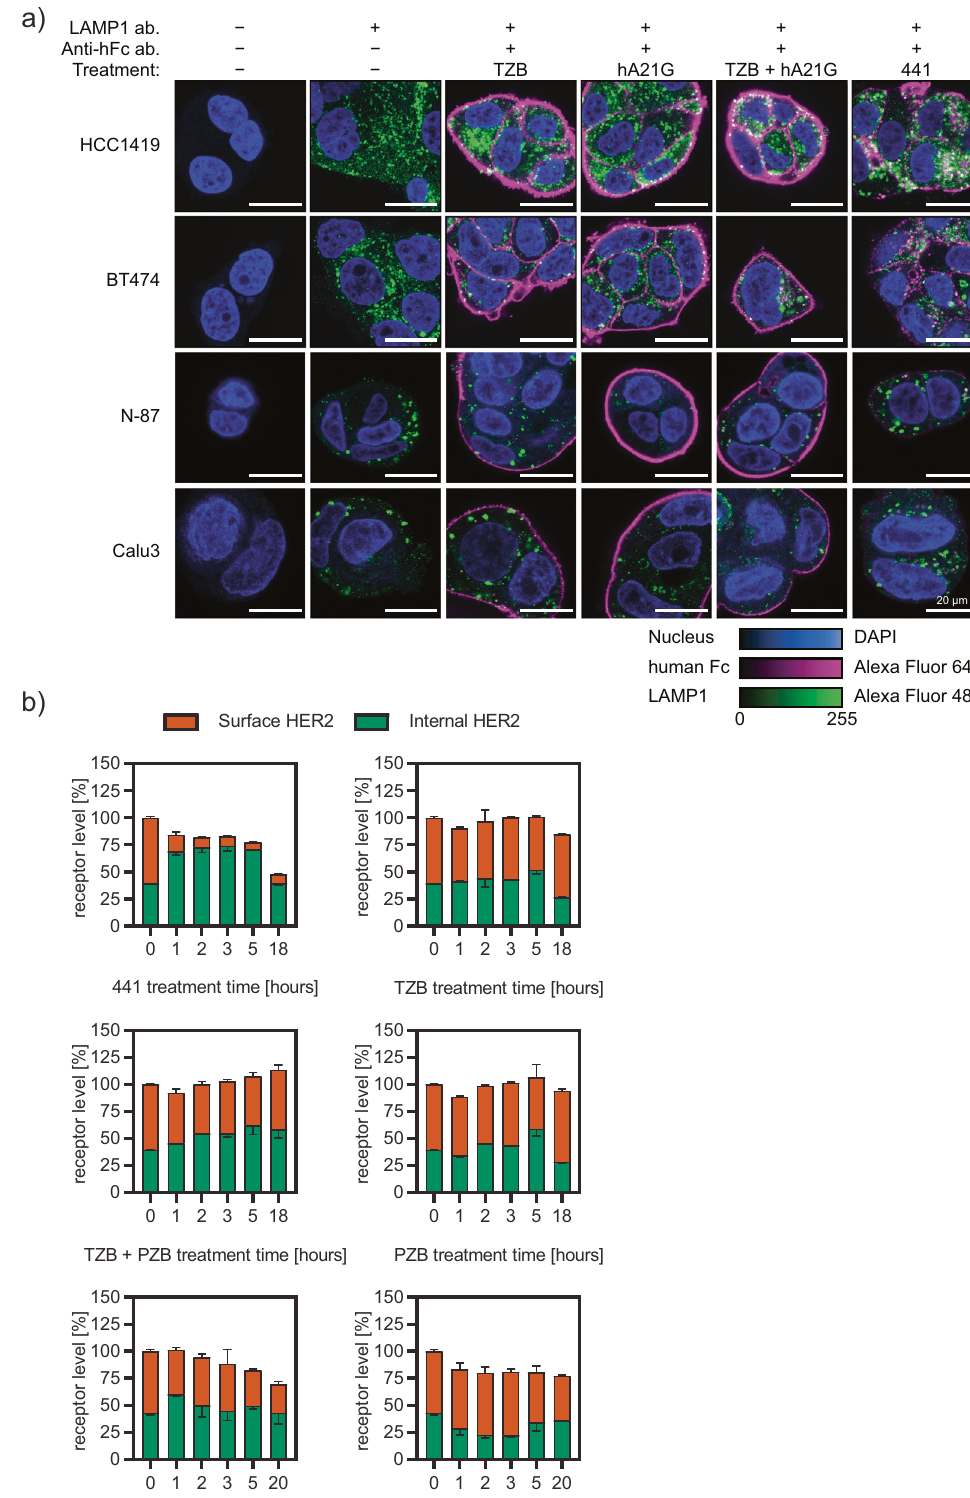
Fig. 5 441 induces internalization and degradation of HER2 clusters. a Qualitative confocal microscopy studies in four different cell lines of different compounds 4 h posttreatment. Continuous membrane staining and retained membrane localization is seen for all mAbs and their combination, expect 441, which is clustered on the surface and internally in lysosomes. Human Fc regions are colored magenta, the lysosomal marker LAMP1 in green and DAPI as nuclear stain in blue. b Internalization and degradation were quantitatively resolved in a time-dependent manner using the recently developed SPIDA protocol 39 (mean plus error bar SD). 441 led to distinct internalization as early as after 1 h, and thereafter internal HER2 was continuously degraded. In contrast, the combination treatment of mAbs leads to a slow gradual decrease of surface HER2, consistent with recycling inhibition without prior intracellular accumulation. Source data are available in the Source Data fi